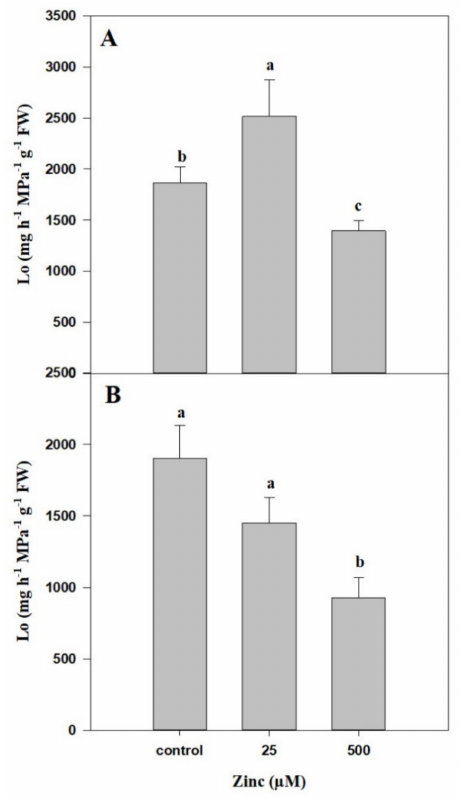
Figure 2. E ff ect of zinc concentration (0, 25 and 500 µ M) on root hydraulic conductance (L 0 ) of pak choi plants, after foliar application. ( A ) Short-term experiment (15 h) in which half of the leaves were sprayed. ( B ) Long-term experiment (15 days). Values are means ± SE ( n = 5). Bars with di ff erent letters represent significant ( p < 0.05) di ff erences after ANOVA and an LSD (Least significant di ff erence)